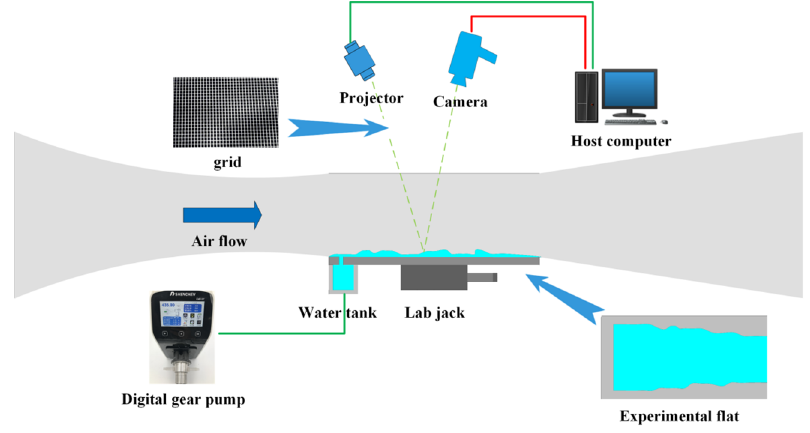
Figure 1. Water film experimental system.